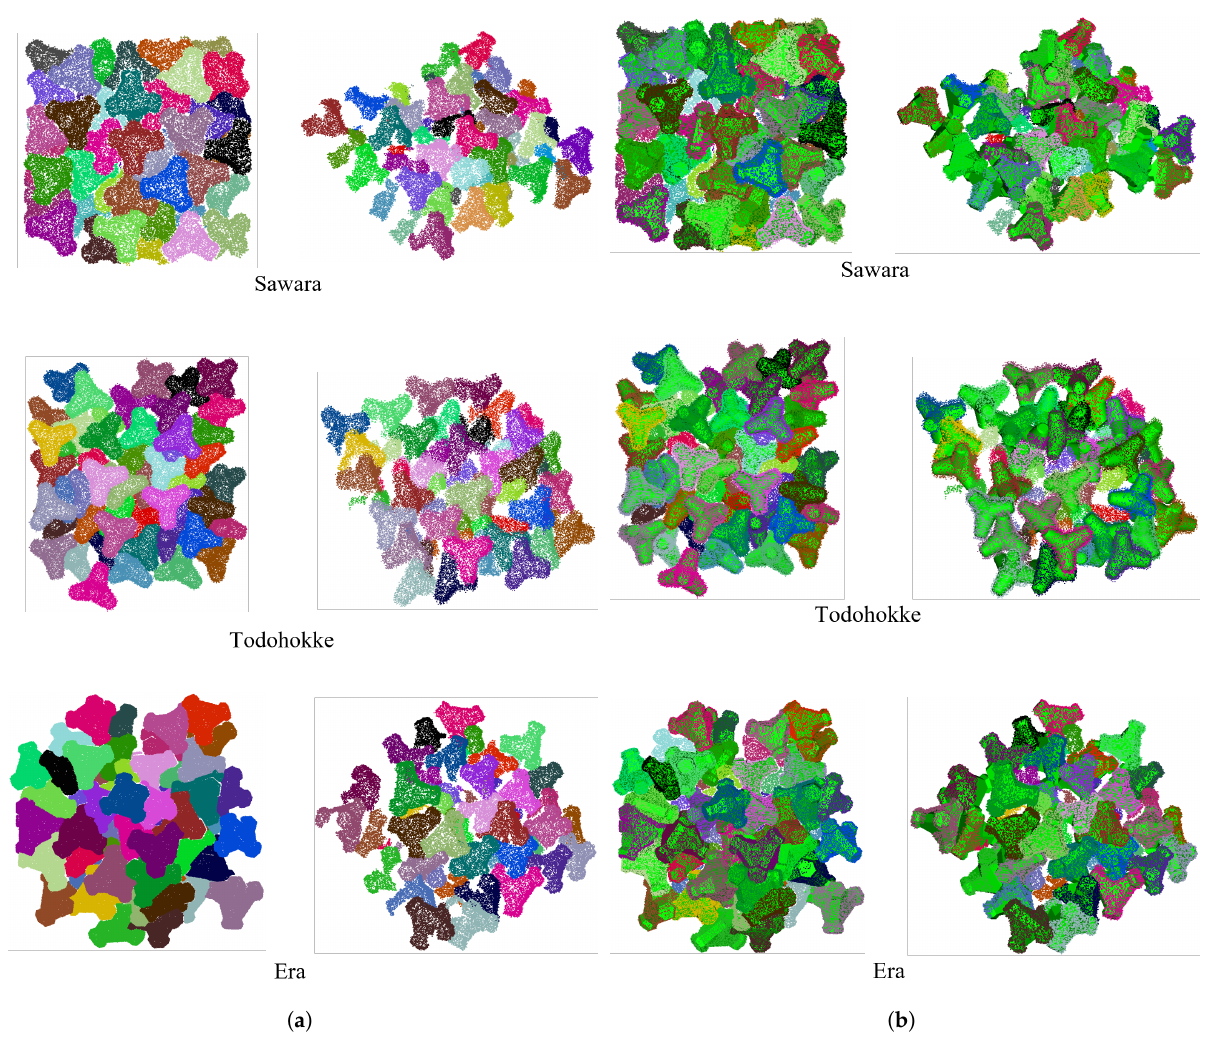
Figure 14. ( a ): Synthetic point clouds for three ports. ( b ): Pose estimation results on synthetic point clouds. Block models are transformed to the scene using estimated